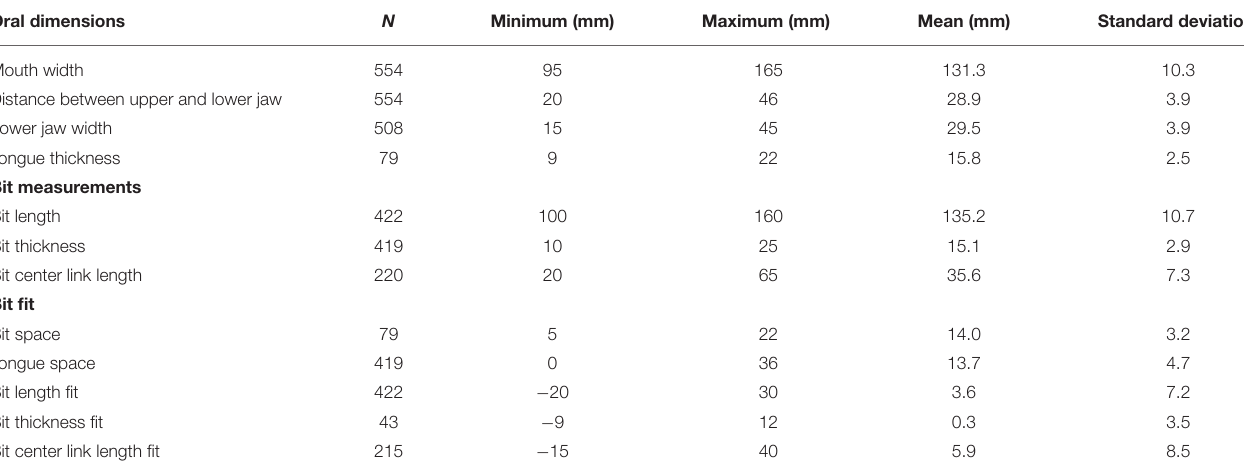
TABLE 3 | Oral dimensions, bit size and bit fit of mares and geldings of different horse and pony breeds ≥ 5